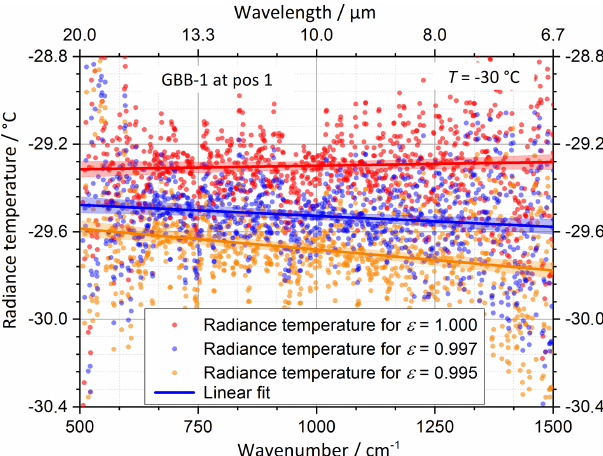
Figure 6. Spectral distribution of the radiance temperatures of the GLORIA reference blackbody BB1 for varying effective emissivi-